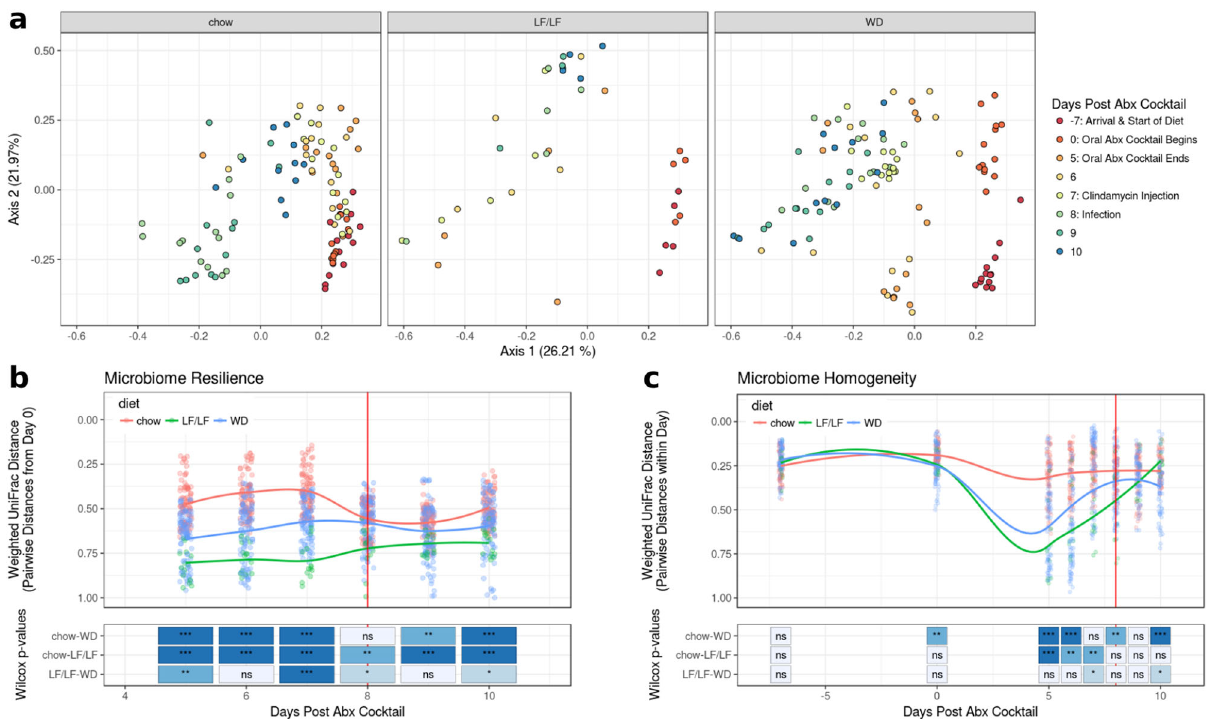
Fig. 5 Beta diversity plots of the fecal microbiome by diet during antibiotic treatment and infection with C. dif fi cile. Vertical red lines in b and c designate the day of C. dif fi cile infection (chow n = 13, LF n = 5, WD n = 13). a Weighted UniFrac PCoA plots of all samples with each diet highlighted in separate panels. b Resilience of microbiome composition assessed by within-mouse pairwise weighted UniFrac distances between day 0 (7 days post diet switch and prior to oral antibiotics) and later time points and c Longitudinal plot of microbiome turnover homogeneity as plotted by intra-time point pairwise Weighted UniFrac distances within diet groups. Signi fi cant differences between diet groups were calculated by Kruskal – Wallis followed by Dunn ’ s post hoc test. Trend lines were fi t using local polynomial regression. *** p < 0.001. ** p < 0.01, * p < 0.05 ns non-signi fi cant.